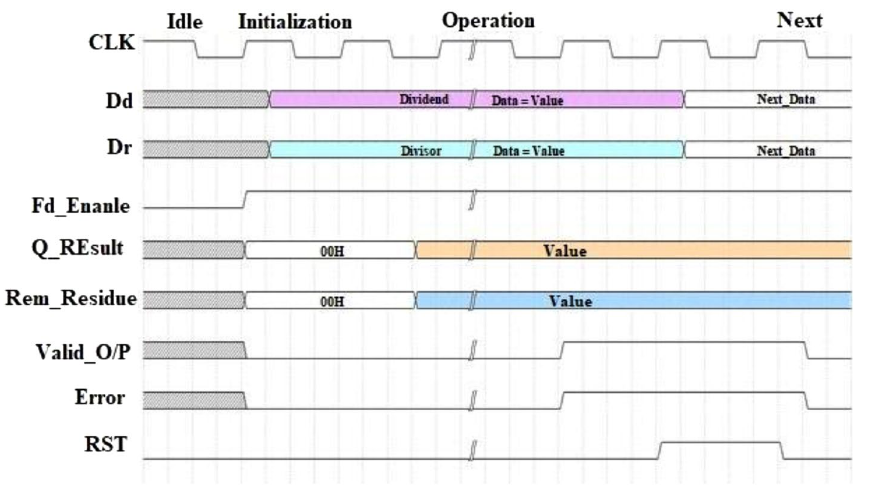
Figure 9. Waveform analysis of the proposed USP-Awadhoot algorithm-based